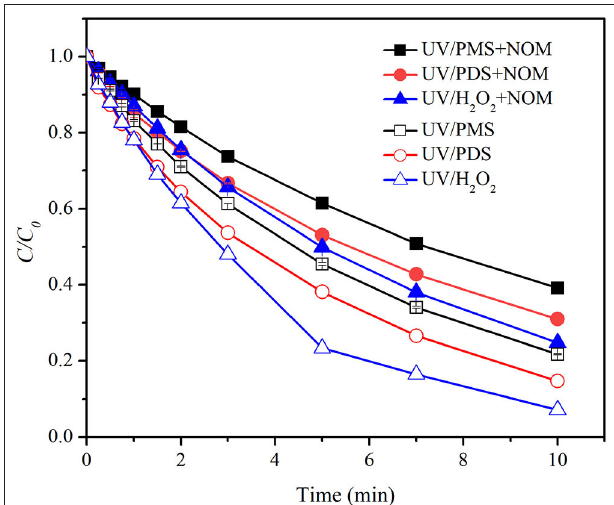
FIGURE 1 | Degradation efficiencies of BA by UV/PMS, UV/PDS, and